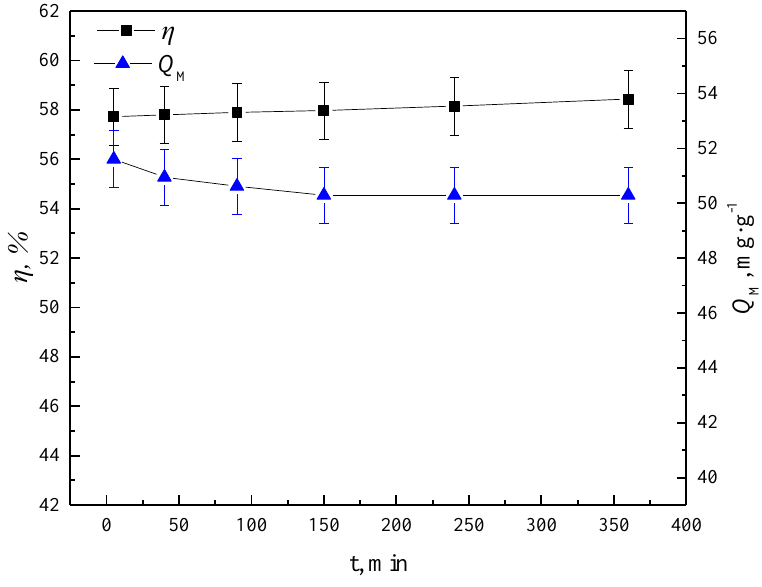
Figure 3. Effects of impregnation time on the impregnation ratio of N-TIRs and adsorption capacity for V(V) (N235: TBP = 9:1, Extractants concentration = 1.6 mol ‧ L −1 ).